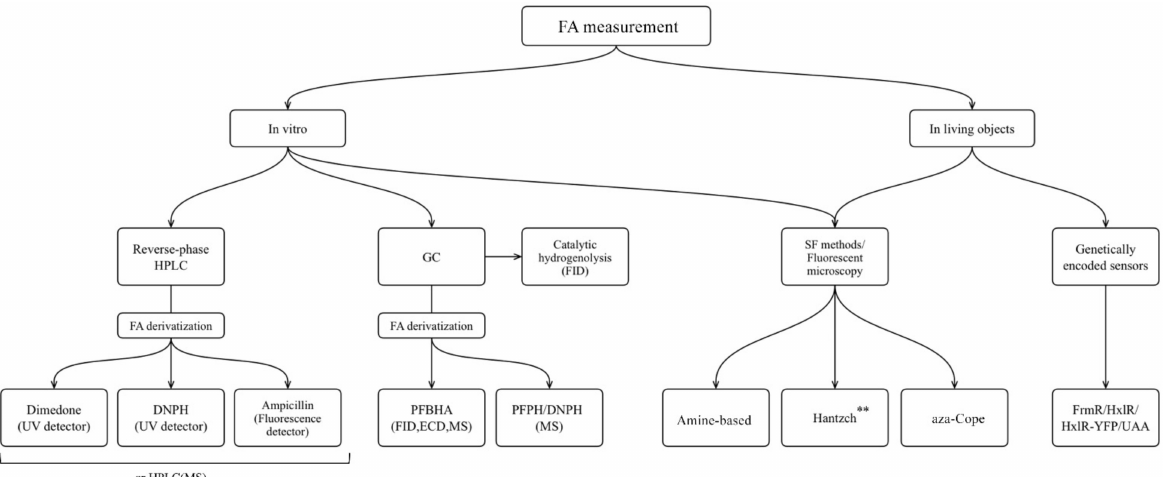
Figure 12. The approaches for FA measurement applicable for different biological samples: HPLC, high performance liquid chromatography; GC, gas chromatography; MS, mass spectrometry; FID, flame ionization detector; ECD, electron-capture detector; SF, spectrophotometry. ** Only Hantzch polymers that do not show cytotoxicity could be used for living